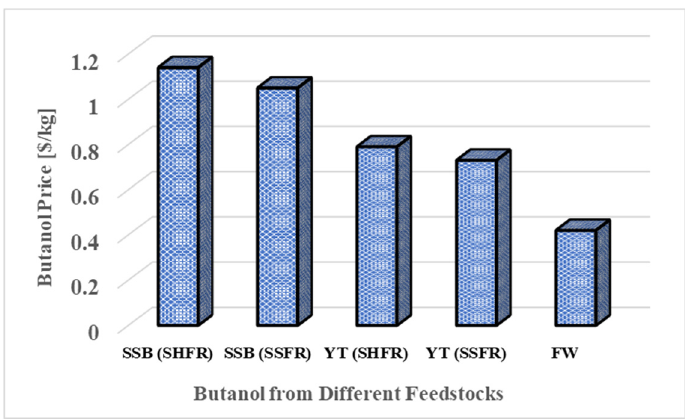
Figure 4. A comparison of butanol selling prices for the various substrates and processes.